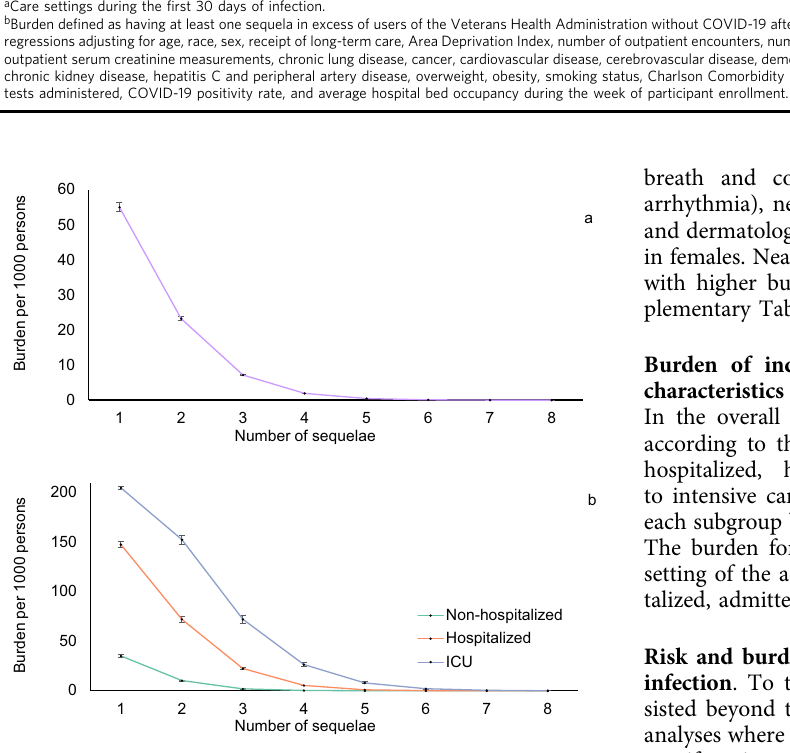
Fig. 2 Burden of post-acute sequelae of COVID-19 as a function of the number of sequelae. a Overall cohort (purple), and b by care setting (non- hospitalized (green), hospitalized (orange), and admitted to intensive care (blue) during the acute phase of the infection). Post-acute sequelae were ascertained from 30 days after infection until the end of follow-up. Estimates of burdens per 1000 COVID-19 patients at 6 months are presented; line represent the estimated burden and error bars represent the 95% con fi dence interval for the corresponding number of sequelae.